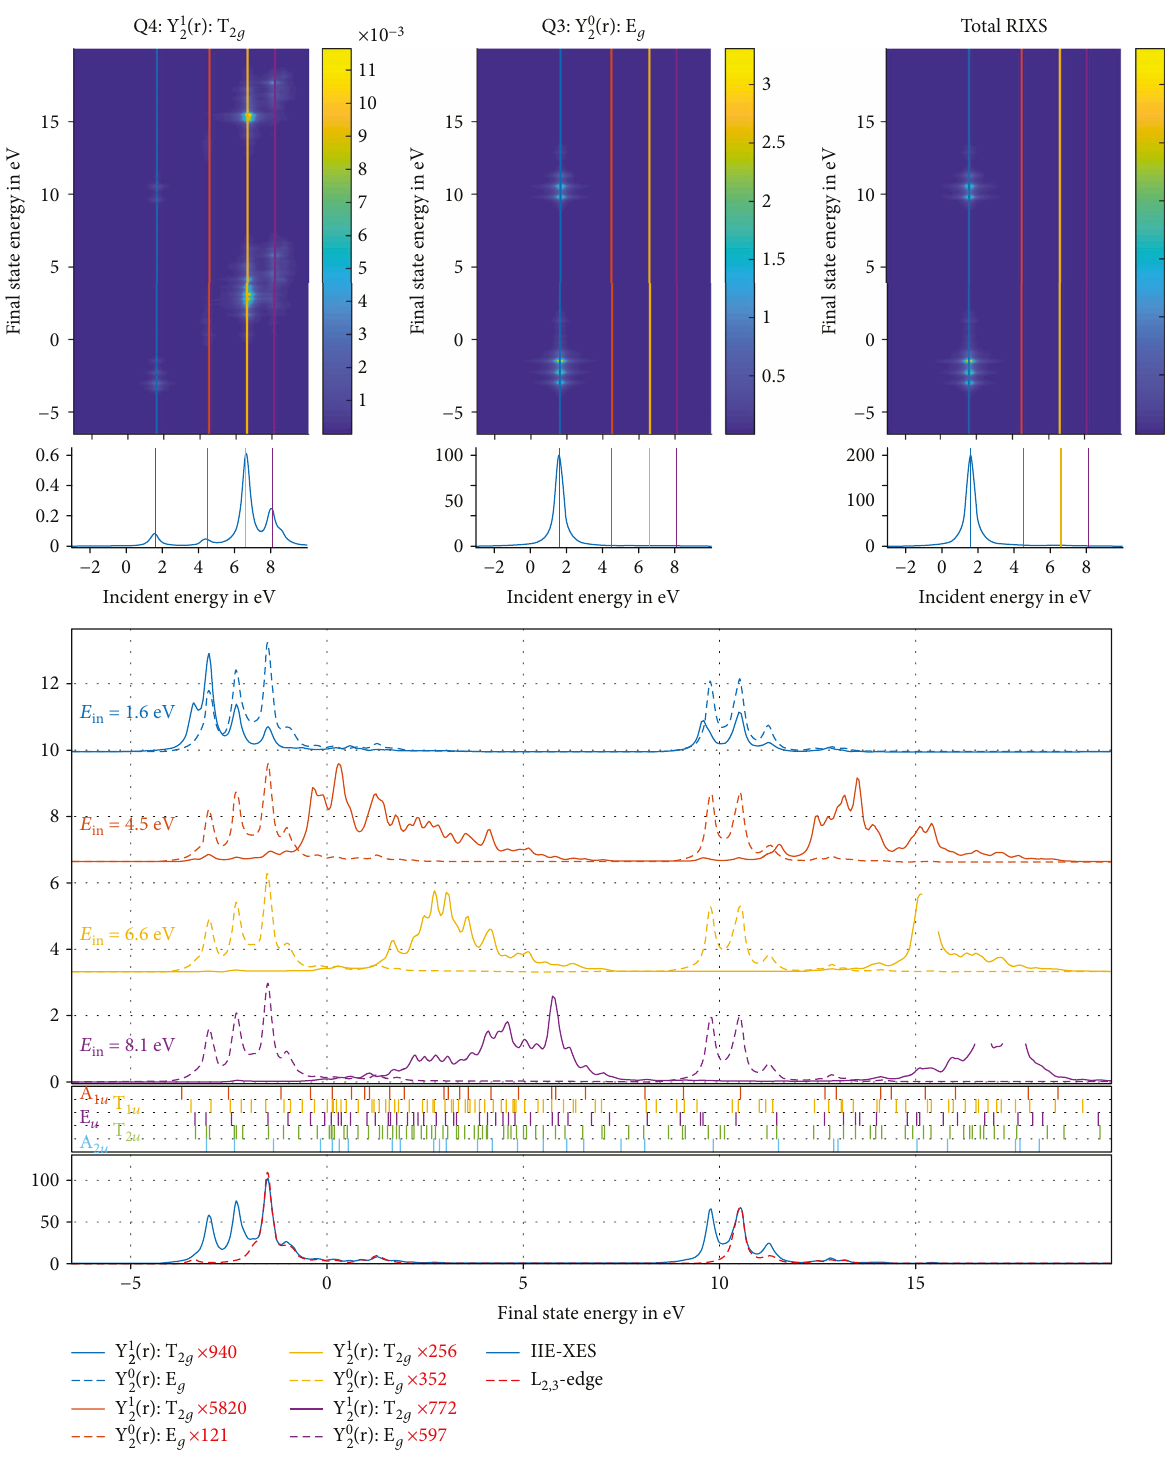
Figure 50: Calculated 1s2p RIXS spectrum for Fe 2+ ( 3d 6 ) for 10D q = 3 0eV (low